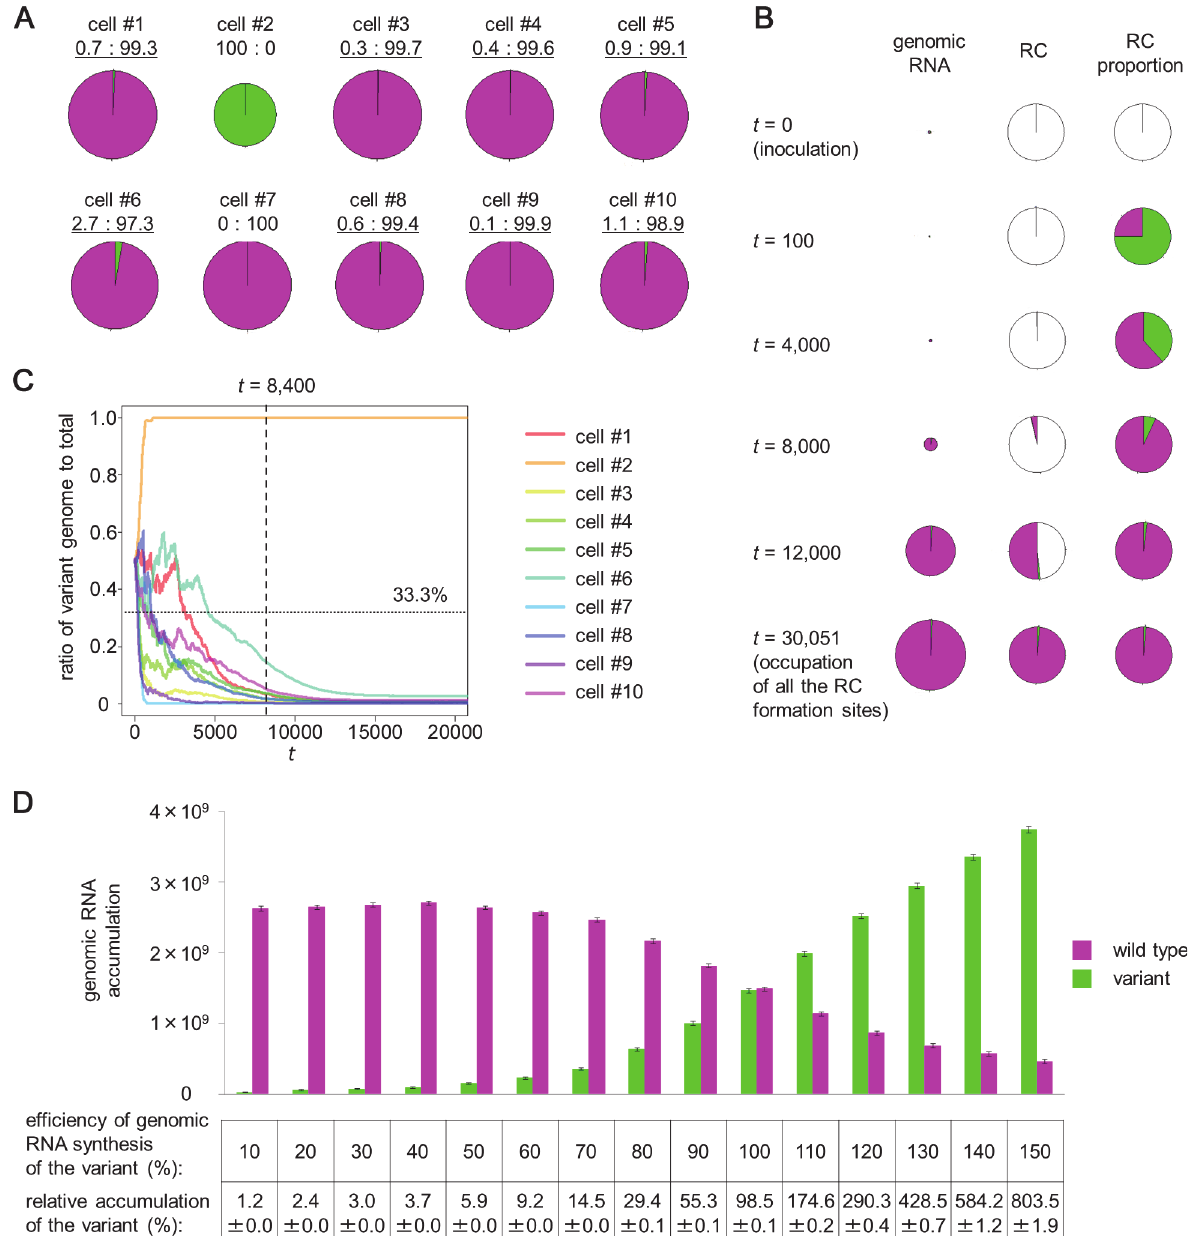
Fig 6. Enhanced bias in progeny accumulation between variants in cis -acting genes or elements simulated by the model. (A) Simulation of the accumulation of the wild type (WT; magenta) and a variant with 50% efficiency of genomic RNA synthesis (green), which were co-inoculated into cells at a 1:1 ratio. Each pie chart shows the amount of genomic RNAs that accumulated in each cell. The accumulation ratios of the variant to WT are indicated below the pie charts, and underlining indicates coinfections. The area size of the pie charts represents the total amount of genomic RNAs. (B) An example of a simulated change in genomic RNA accumulation and replication complex (RC) site occupancy over time in a cell coinfected with the WT (magenta) and a variant with 50% genomic RNA synthesis efficiency (green). (C) History of changes in the ratio of the variant to total genomes in cells 1 – 10 of panel A. The dashed line indicates t = 8,400, which corresponds to experimental * 4 hpi. The efficiency of genome RNA synthesis of the variant is 50% of that for the co- inoculated WT RNA; therefore, a variant to total ratio of < 33.3% [i.e., 50%/(50% + 100%)] indicates the occurrence of enhanced bias in progeny accumulation (EBPA). The dotted line indicates 33.3% accumulation of the variant. (D) The accumulations of WT (magenta) and co-inoculated variants with different genomic RNA synthesis efficiencies (green) in 1,000 cells were simulated. The relative accumulation of the variants is also shown in a table below the bar graph. Means ± SEs calculated using bootstrap analysis of 1,000 simulated cellular infections are shown. R scripts S9 Text and S10 Text were used to generate panels A – B and C, respectively. S9 Text was also used to generate S2 Movie. To generate panel D, R scripts S11 Text and S12 Text were used, and the data obtained by the authors are shown in S4